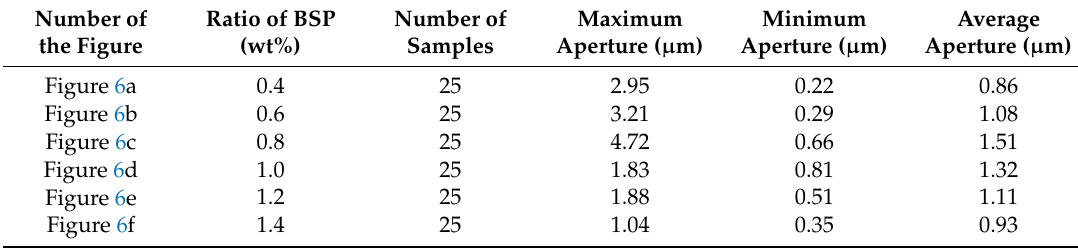
Figure 6. SEM of composite films. ( a ) Represents a BSP ratio of 0.4%; ( b ) represents a BSP ratio of 0.6%; ( c ) represents a BSP ratio of 0.8%; ( d ) represents a BSP ratio of 1%; ( e ) represents a BSP ratio of 1.2%; ( f ) represents a BSP ratio of 1.4%. Table 4. Aperture Size Table of Composite